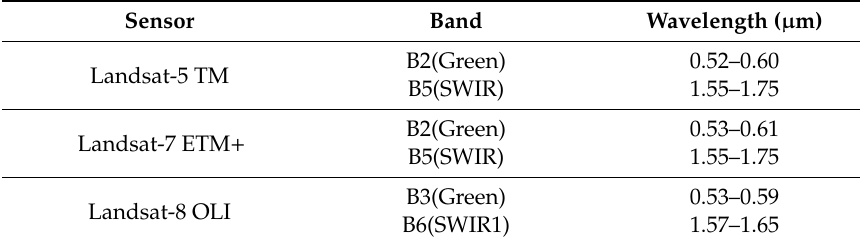
Table 3. Di ff erent sensors correspond to band information of Green and MIR. Sensor Band Wavelength ( µ